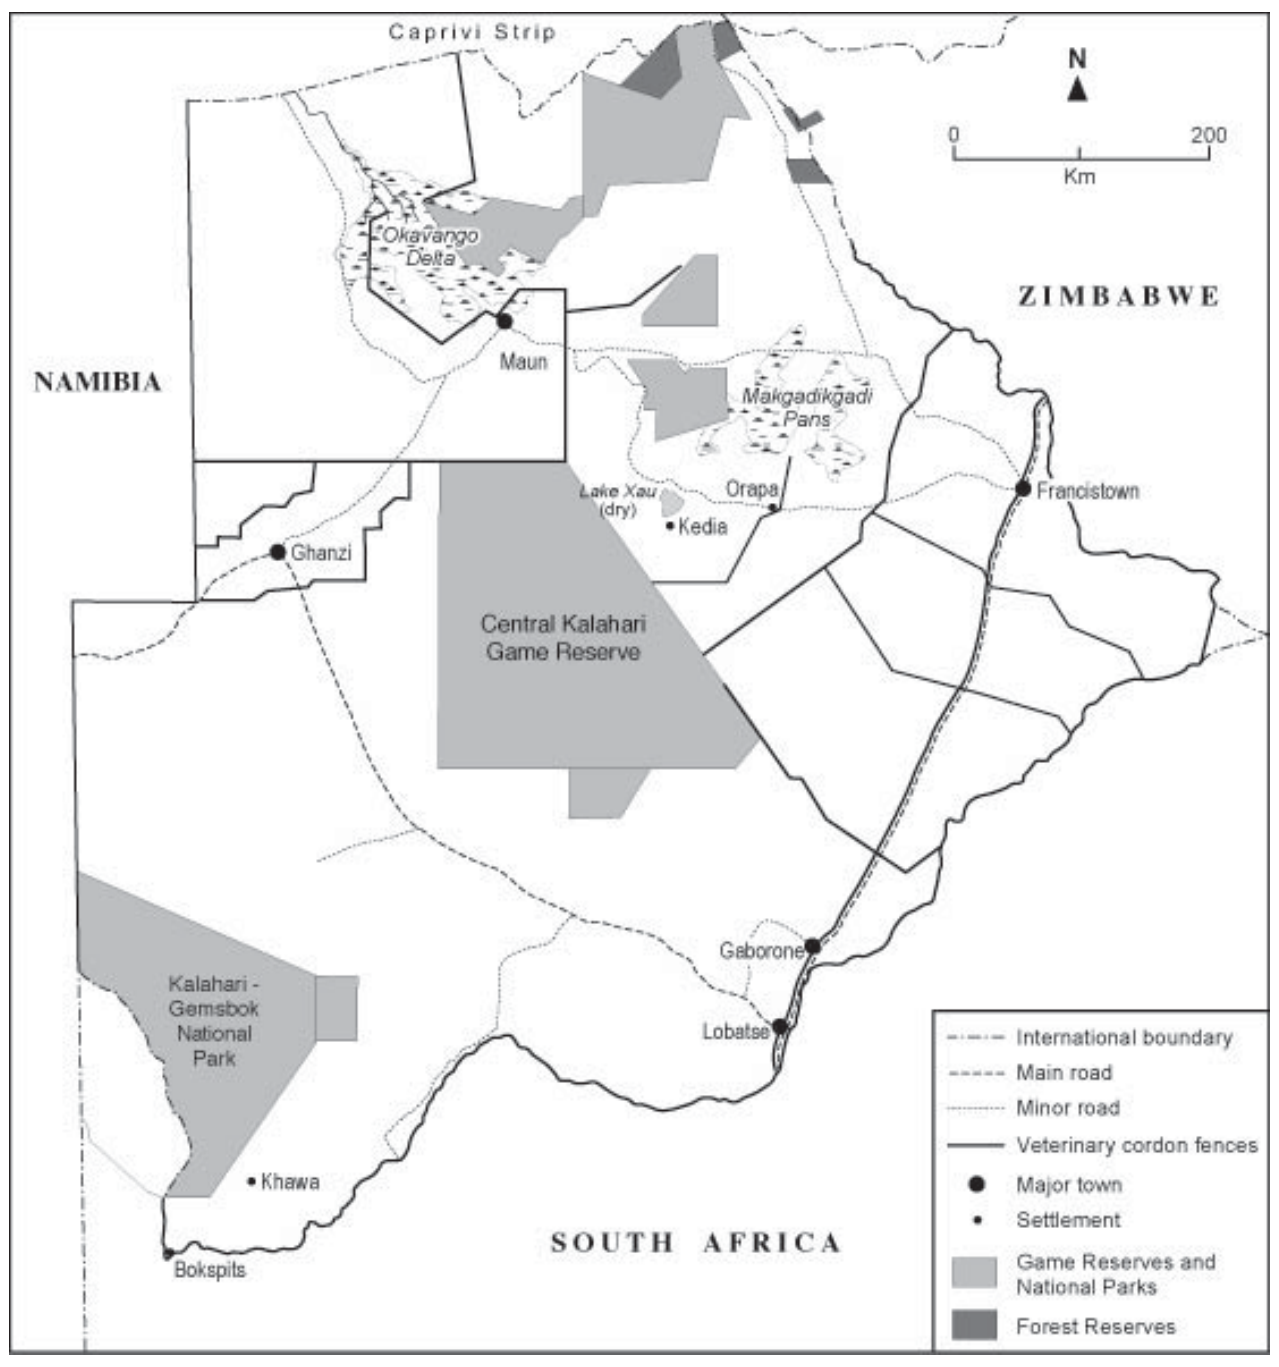
Fig. 1 . Location of study settlements Khawa and Kedia,